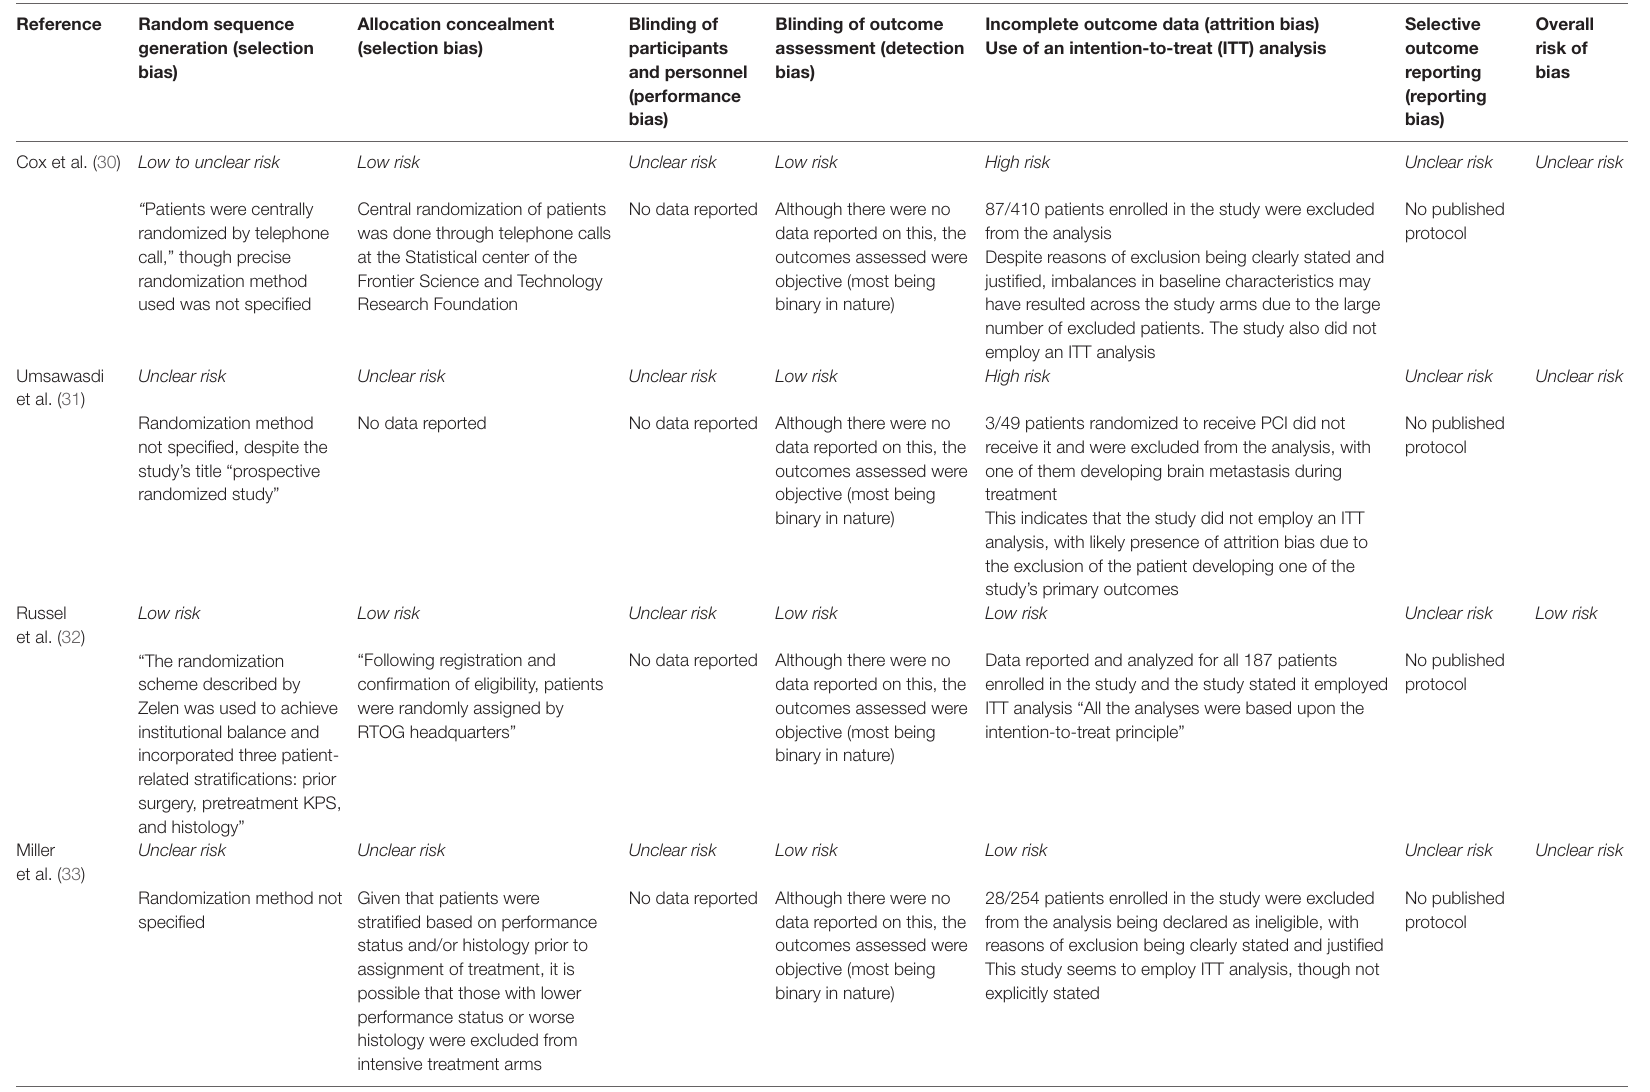
taBLe 2 | Risk of bias assessment for the included